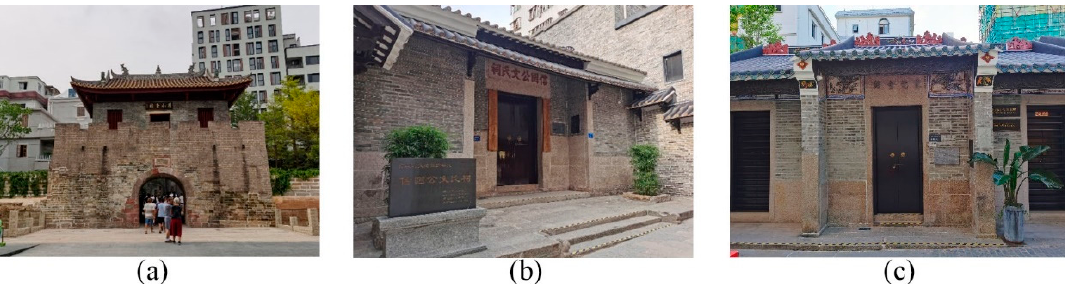
Figure 2. Primary historical buildings of Nantou Ancient City (( a ). South Gate of Nantou Ancient City, ( b ). Xinguogong Wen Ancestral Hall, ( c ). Dongguan Club).